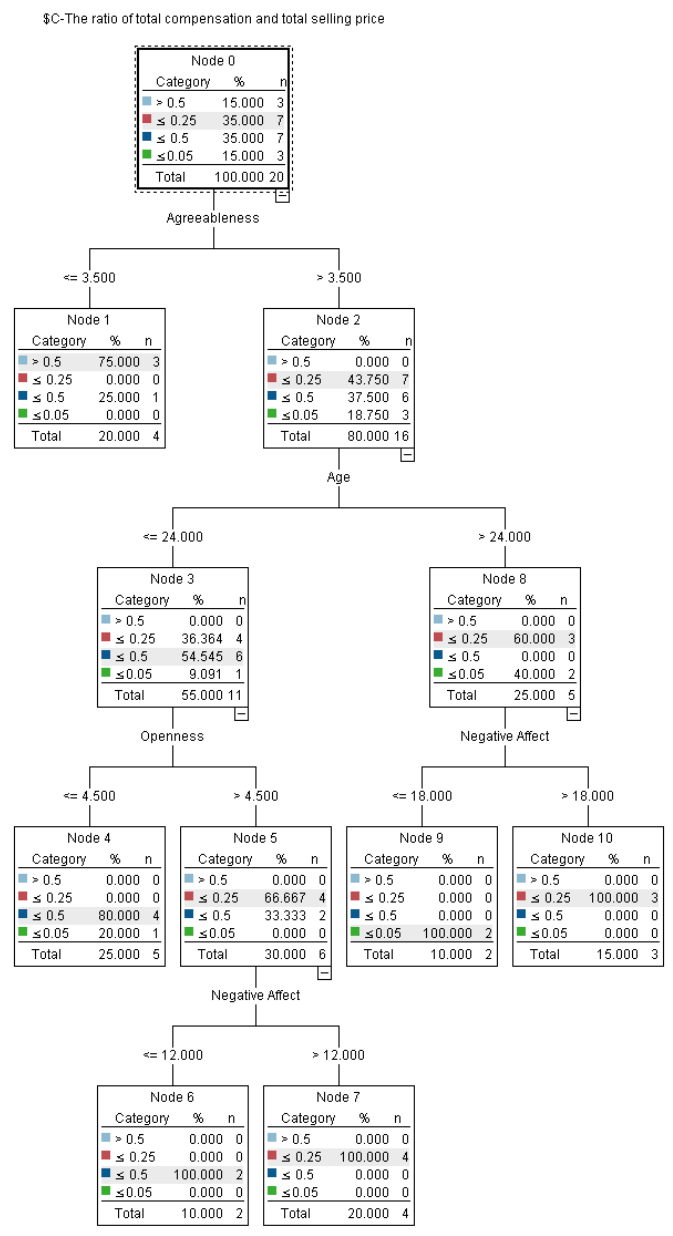
Figure A1. Decision tree.